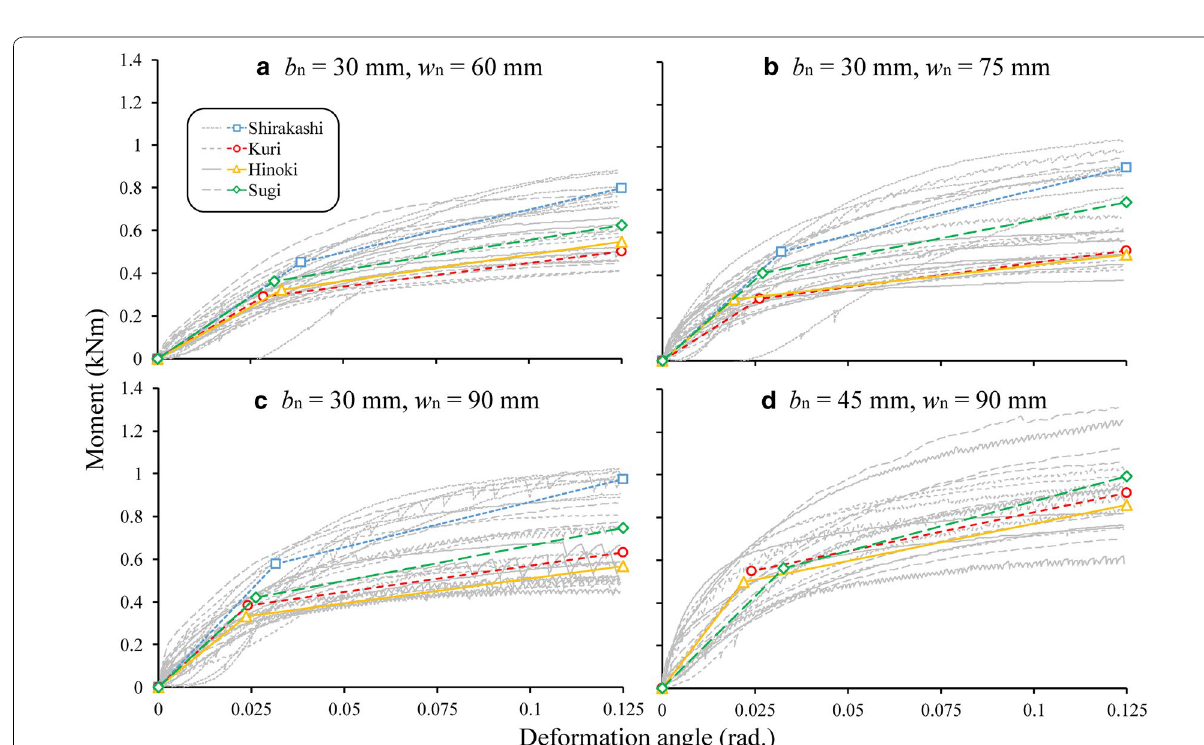
Fig. 3 Relations between moment and deformation angle and bilinear showing the average of characteristic (N series) [8]. The closed symbols, in the order of deformation angle, indicate the origin, the average of the coordinate of yield point, and the one of maximum moment. The gray lines show the results for each